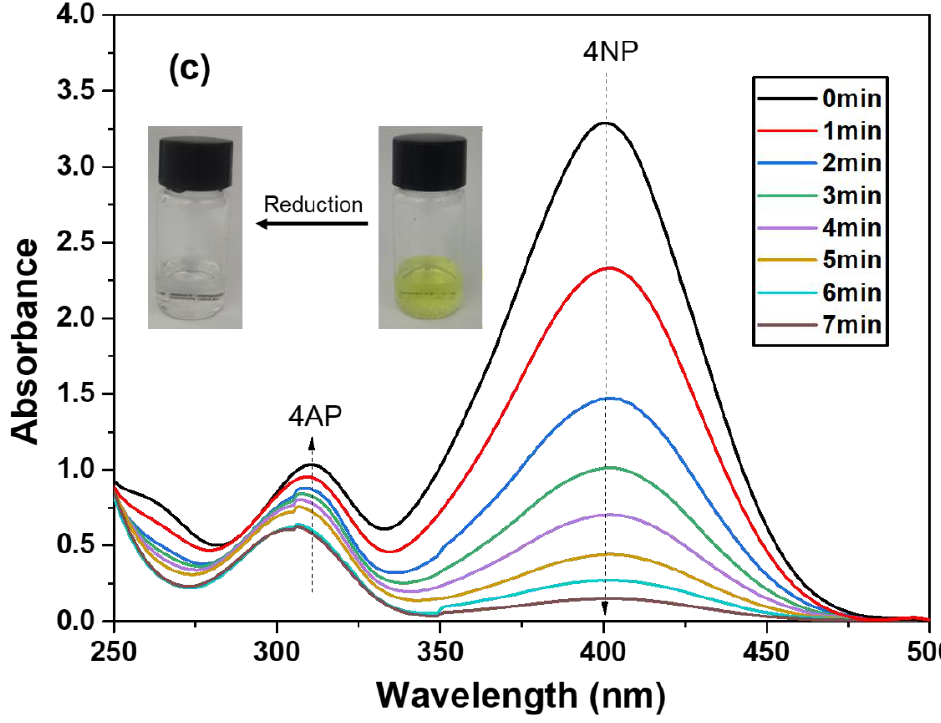
Figure 7. Catalytic conversion of 4NP to 4AP using the ( a ) ZrP/Au, ( b ) PDA/Au and ( c ) ZrP@PDA/Au catalysts.